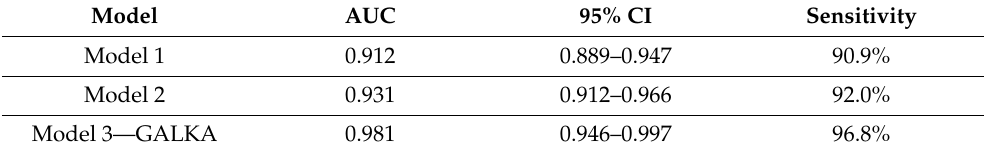
Table 4. Models(cid:31) performance for discriminating HCC ( n = 80) and CLD ( n = 139) (speci fi city = 90%). Table 4. Models’ performance for discriminating HCC ( n = 80) and CLD ( n = 139) (specificity = 90%). Model Model AUC 95% CI Sensitivity Model 1